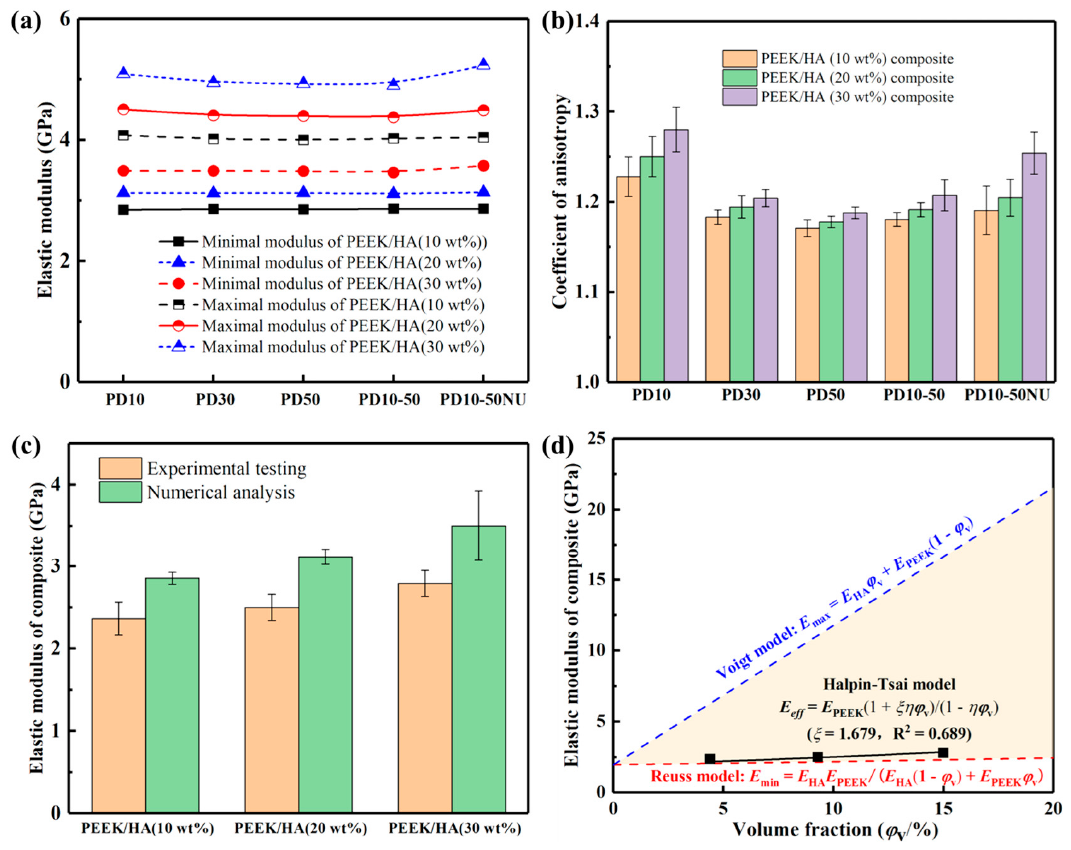
Figure 6. The elastic moduli of PEEK/HA composites: ( a , b ) The influence of particle diameter and dispersion on the modulus and anisotropic coefficient; ( c ) The comparison of elastic moduli between experimental testing and numerical analysis; ( d ) The mathematical model for effective elastic moduli of PEEK/HA composites; PD 10–50 NU denotes nonuniform distribution of HA particles with a diameter of 10–50 μ m.